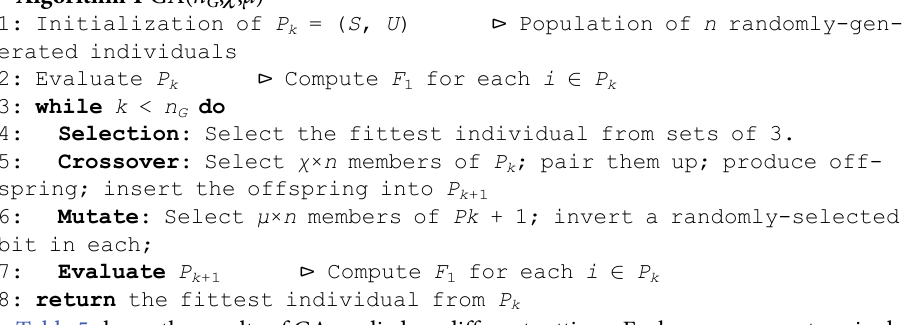
Algorithm 1 GA( n